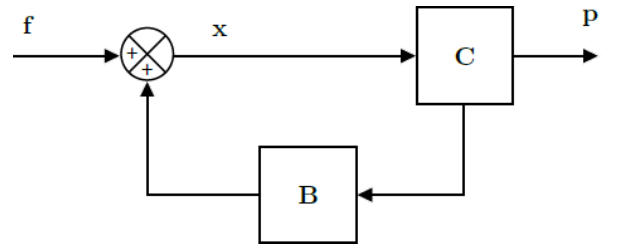
Figure 2 illustrates a block diagram representation of Whiten’s cone crusher model.